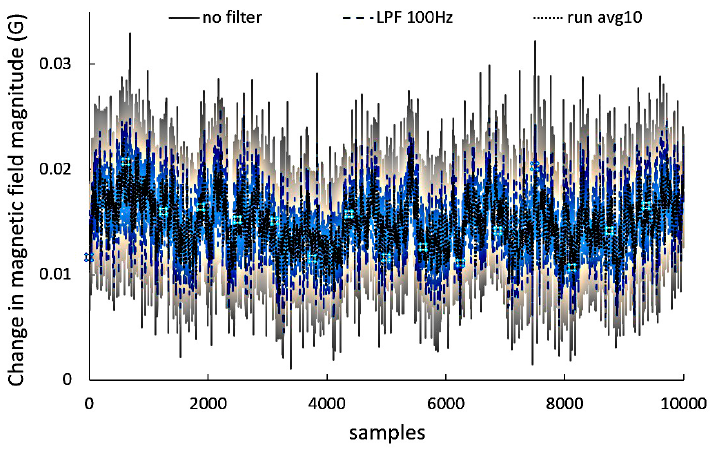
Figure 3. The change in the magnitude of the background magnetic field, noise and filtering effect.